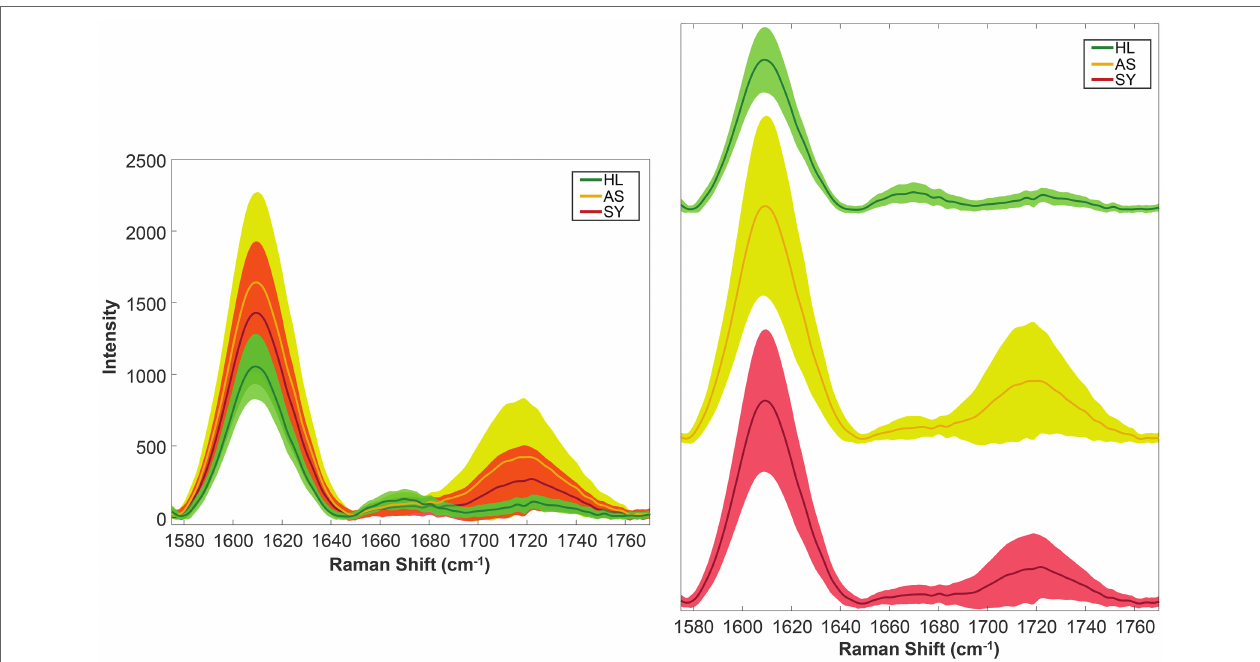
FIGURE 1 | Rose leaf mean spectra (solid lines) and standard deviations (shaded regions). Left—stacked; right—offset vertically for clarity. HL—Healthy control; AS—asymptomatic;